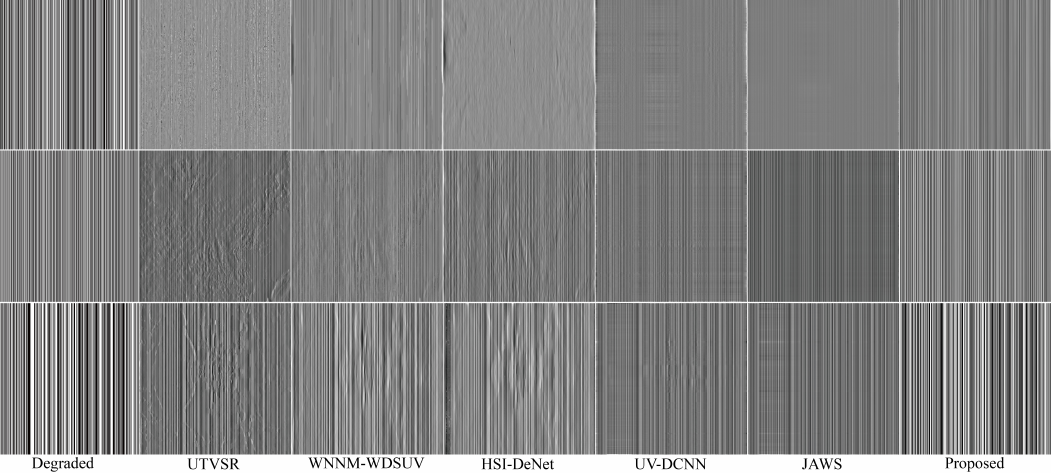
Figure 12. Visual comparisons of the estimated stripes corresponding to the SAM1 , STM2 , and SWDC images in Figure